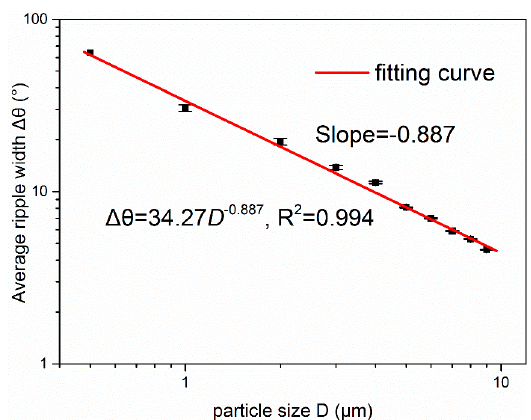
Figure 3. The calculated relationships between the averaged ripple width and particle size for quartz particles.